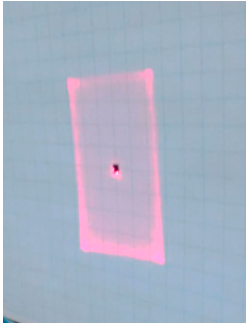
Figure 8. Bi-axial laser projection by the CMOS MEMS scanning